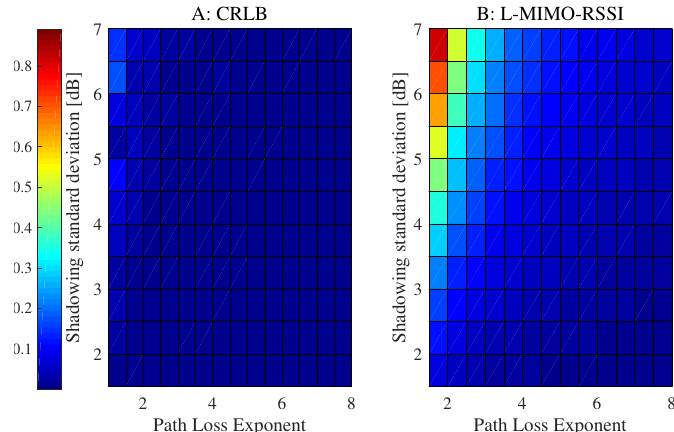
Figure 19. Cramér–Rao Lower Bound (CRLB) for different path loss exponent and shadowing standard deviation values.